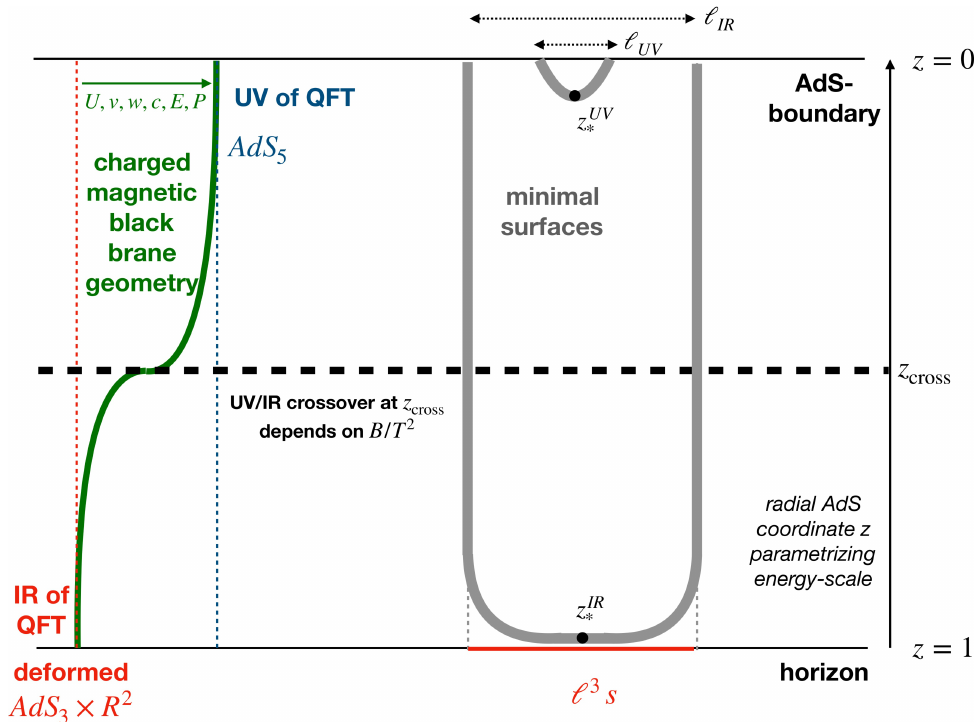
Figure 1 . Schematic plot of the energy scale of the boundary theory prepared in a thermal state as it is encoded in the bulk geometry. The AdS radial coordinate z is dual to the energy scale of the field theory. The magnetic field scale B/T 2 determines the charged magnetic black brane geometry (at fixed chemical potential µ/T ). Large B/T 2 pushes the transition from IR-like geometry (deformed AdS 3 × R 2 near the horizon) to UV-like geometry ( AdS 5 ) towards the AdS-boundary. Minimal surfaces, indicated by thick grey lines, are dual to the entanglement entropy of a strip of width ‘ in the boundary theory. Depending on the value of ‘ , they probe either the UV or the IR or intermediate scales of the boundary theory evaluated in a particular state. The point on the minimal surface closest to the horizon is labeled z ∗ , and corresponds to the energy scale probed by the entanglement entropy. We stress that the geometry as a function of the AdS radial coordinate z encodes both, the RG-flow of the boundary field theory and simultaneously the energy-dependence of the